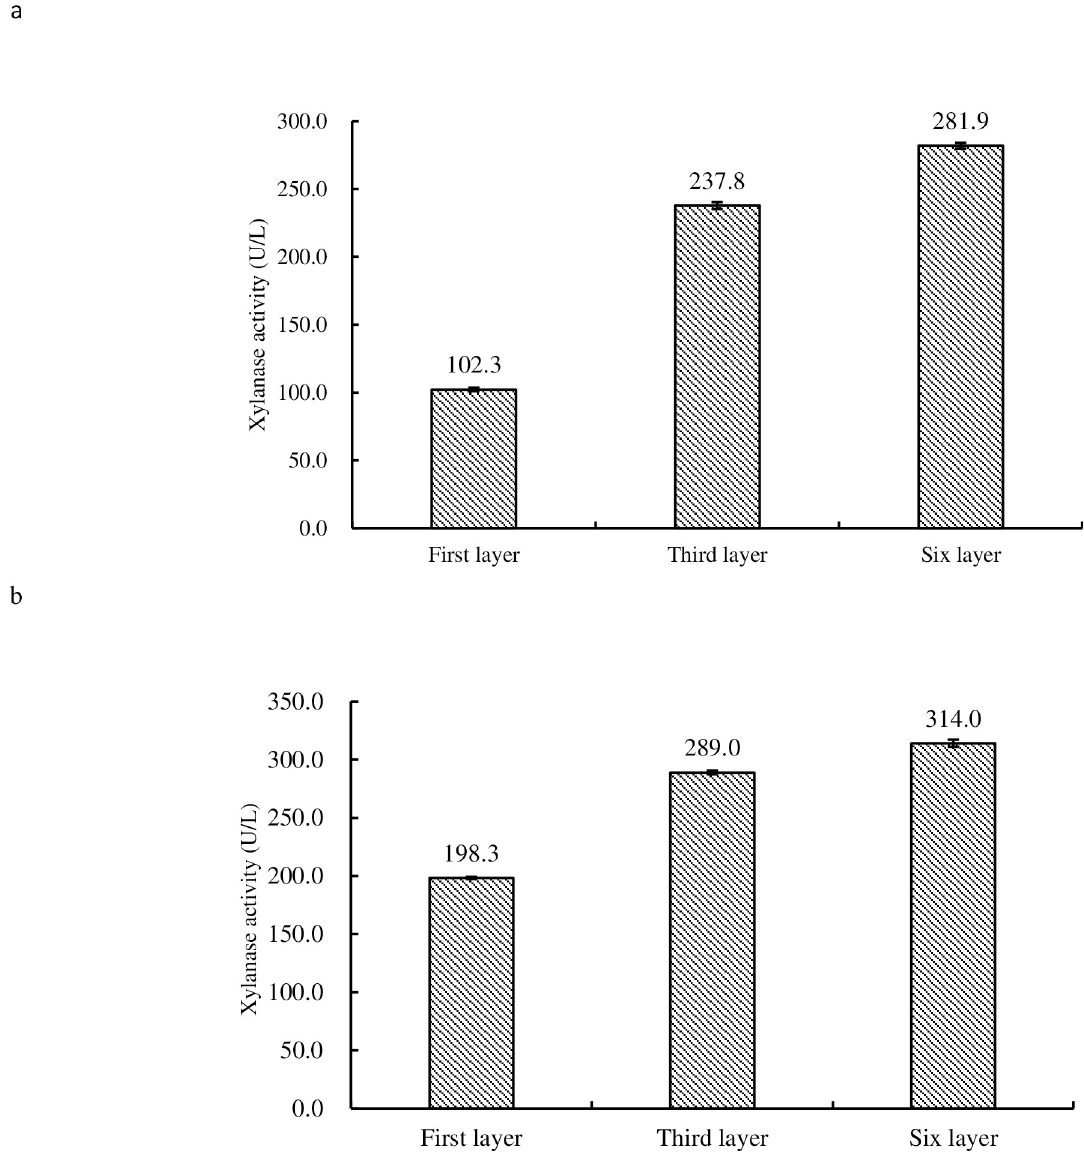
Fig 5. Comparison of xylanase activity in budding fruiting bodies (5a) and mature fruiting bodies (5b) of 1 st , 3 rd and 6 th tier of H . marmoreus